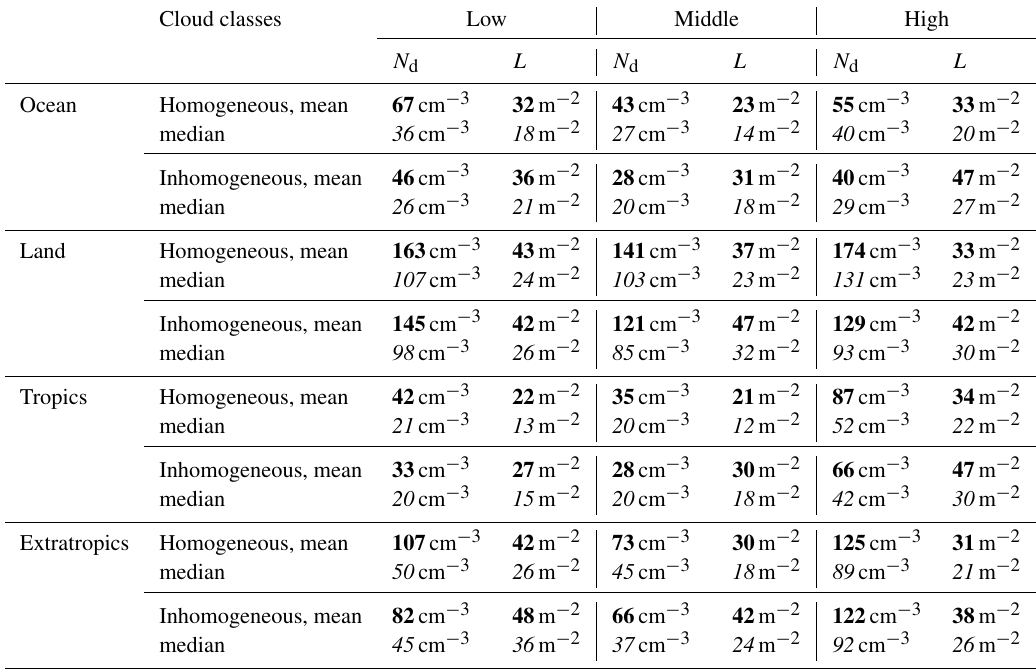
Table A1. Average (bold) and median (italic) values of N d and L for the six particular cloud classes derived from their PDFs, but separated, but separated for ocean, land, the tropics (20 ◦ S–20 ◦ N) and the extratropics (40–60 ◦ S and 40–60 ◦